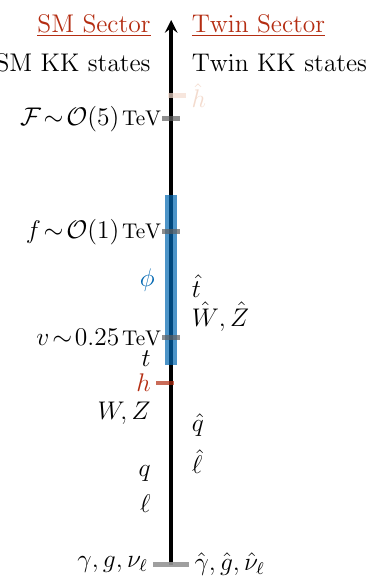
Figure 2 . Spectrum of the dilaton portal holographic mirror twin Higgs